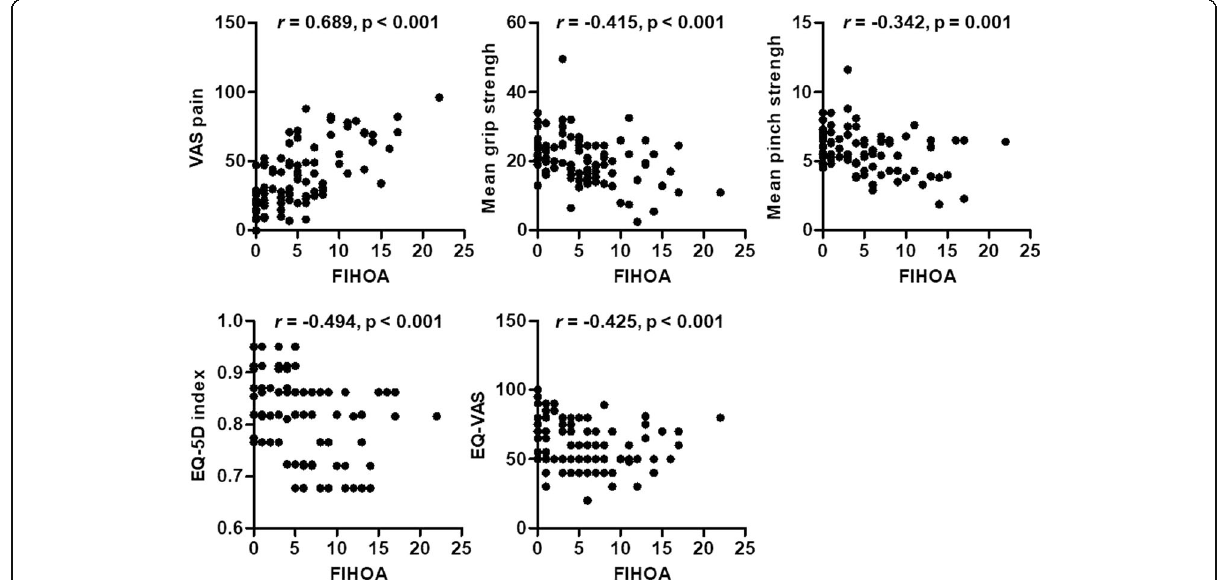
Fig. 1 Correlation of FIHOA with VAS pain, hand strength, and EQ-5D. Abbreviation: VAS, visual analogue scale; FIHOA, Functional Index for Hand Osteoarthritis; EQ-5D, EuroQol-5